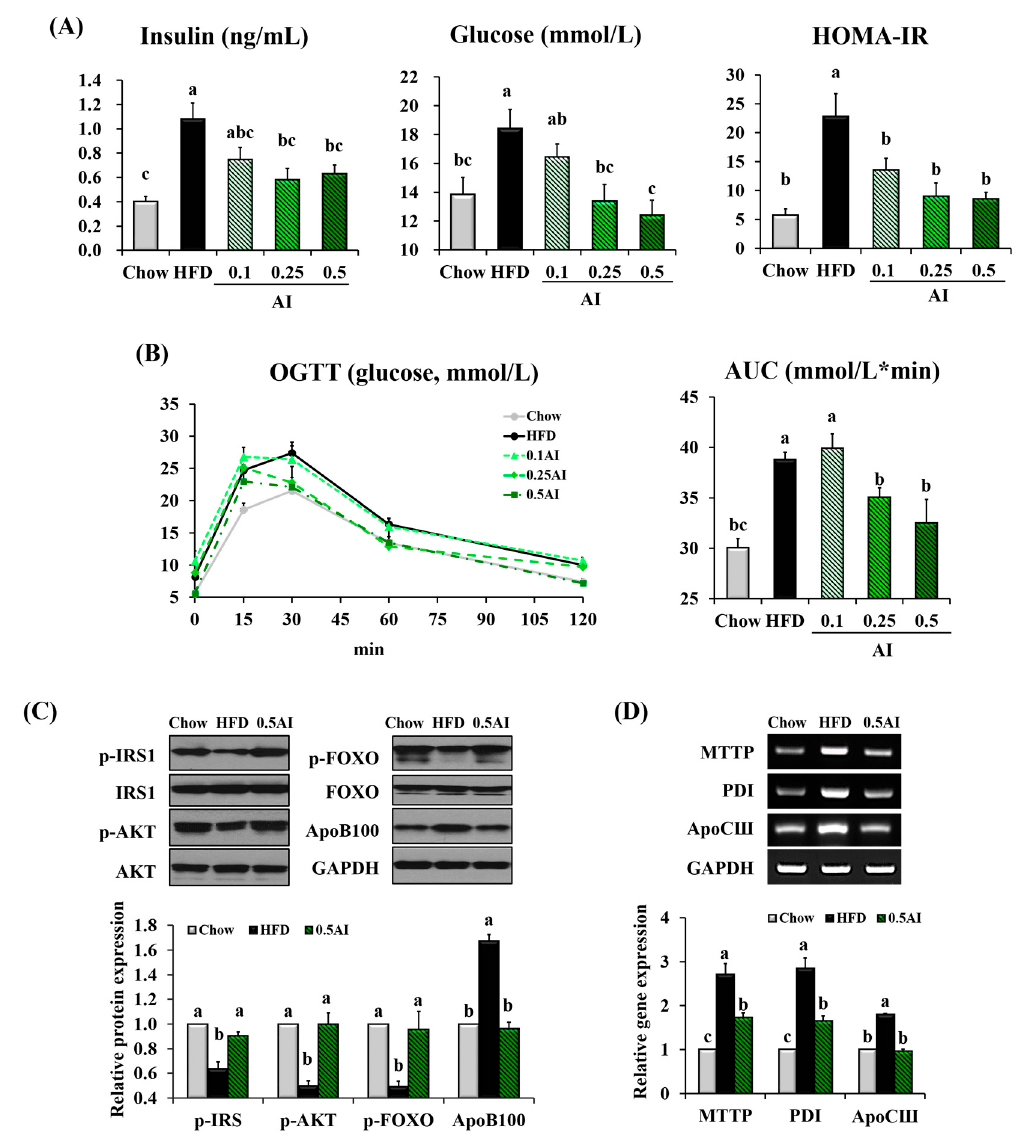
Figure 5. AI improves the hepatic insulin signaling pathway in mice. ( A ) Fasting plasma levels of insulin and glucose and homeostasis model assessment of basal insulin resistance (HOMA-IR)) index; ( B ) oral glucose tolerance test (OGTT) and area under the curve (AUC); ( C ) densitometric quantification of the phosphorylation of IRS1, AKT, FOXO, and ApoB100 in the liver; ( D ) hepatic expression of genes involved in VLDL assembly; Statistical analysis was performed using one-way ANOVA and analyzed further by Duncan’s multiple range test. Different letters above the bars indicate significant differences among experimental groups ( p <